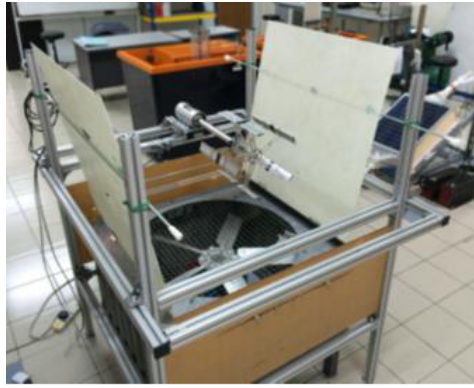
Figure 2. Experimental apparatus.